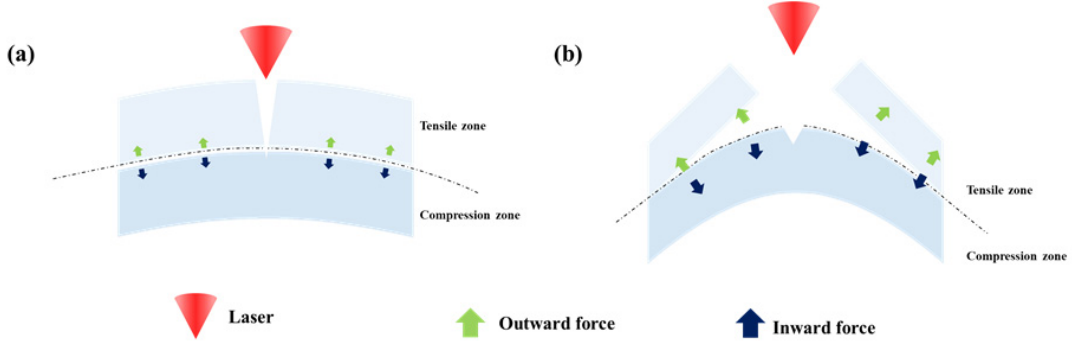
Figure 9. Process of delamination phenomenon during processing according to the degree of curvature of polymer ( a ) smaller curvature (no delamination), ( b ) bigger curvature.